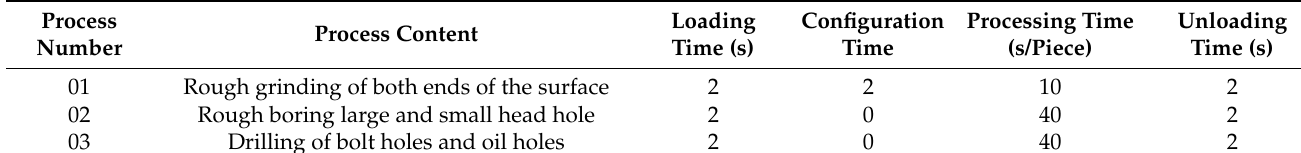
Table 3. The process table of the first part of the processing area.